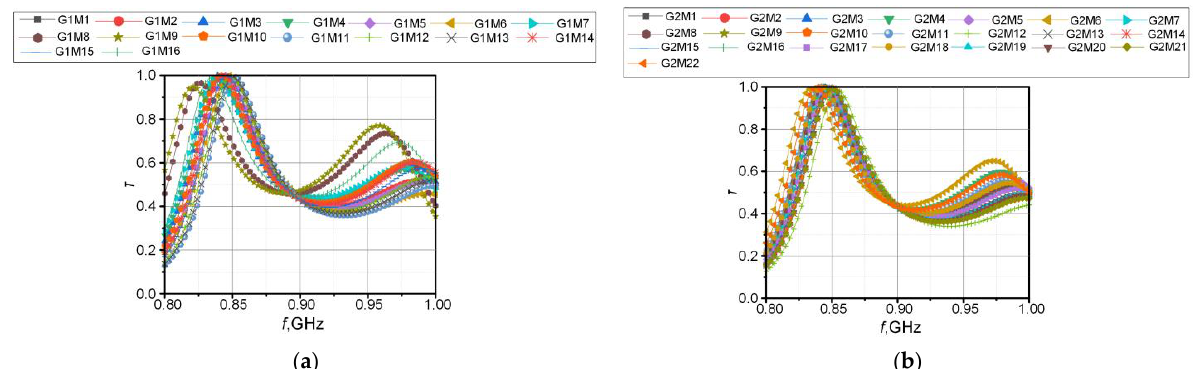
Figure 16. Complex impedance of RFIDtex transponder antenna depending on textile substrate: ( a ) Group G1; ( b ) Group G2.